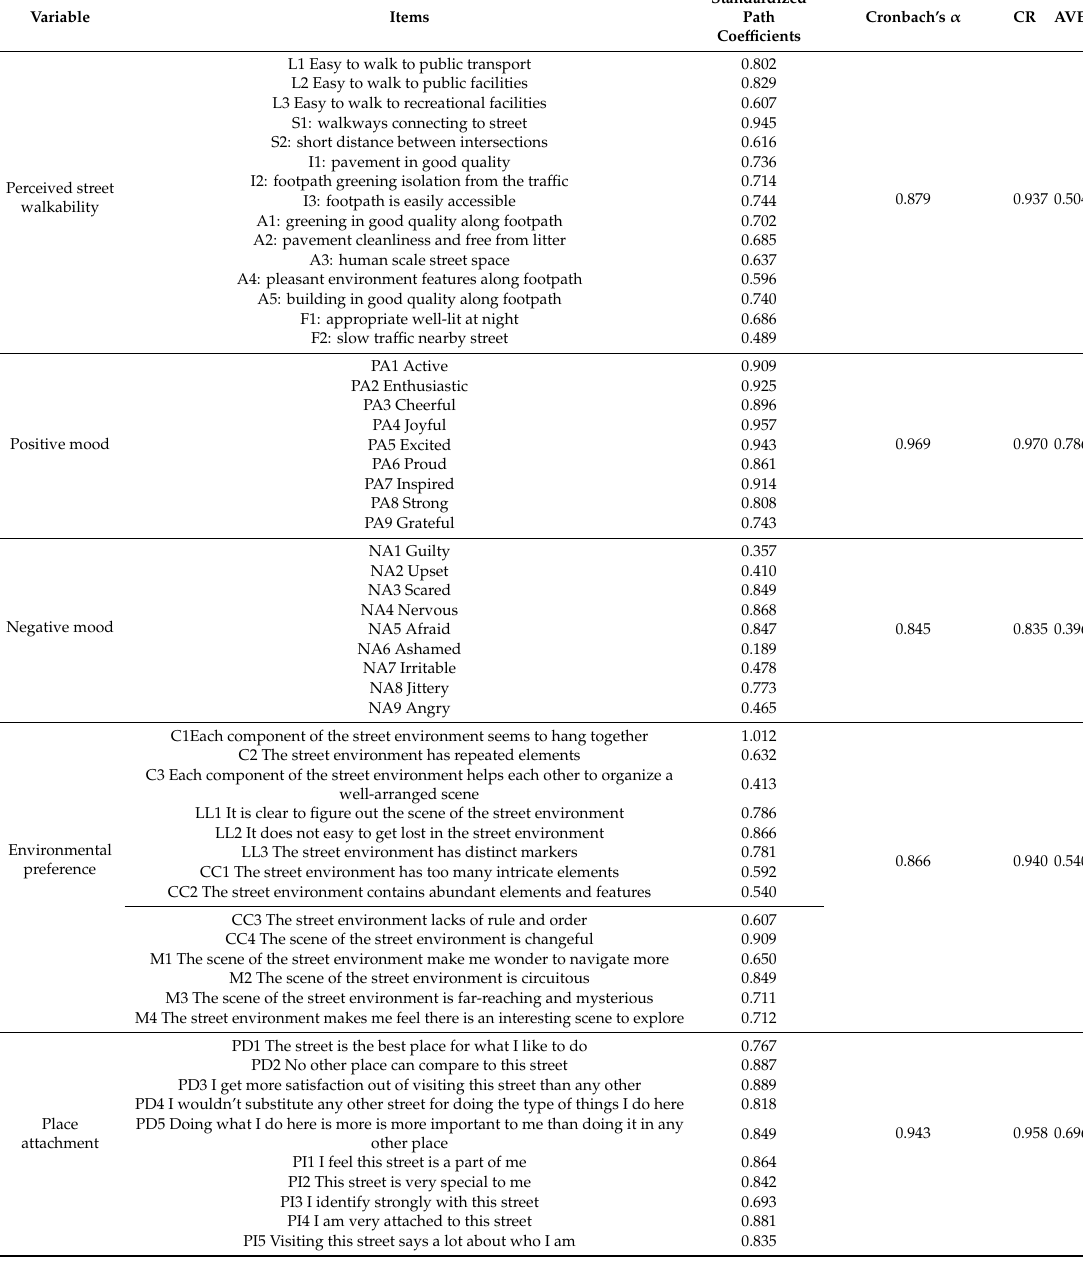
Table 2. Reliability and validity analysis.